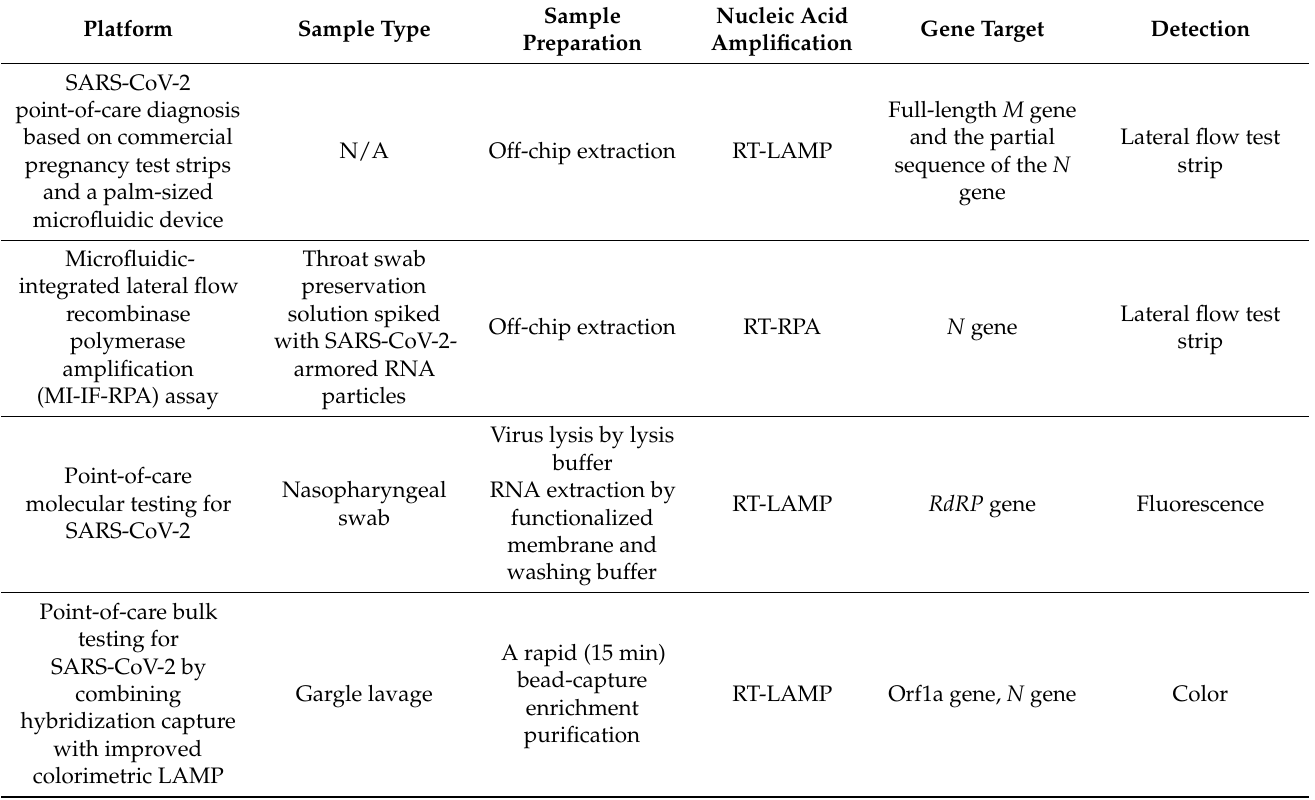
Table 3. SARS-CoV-2 diagnostic